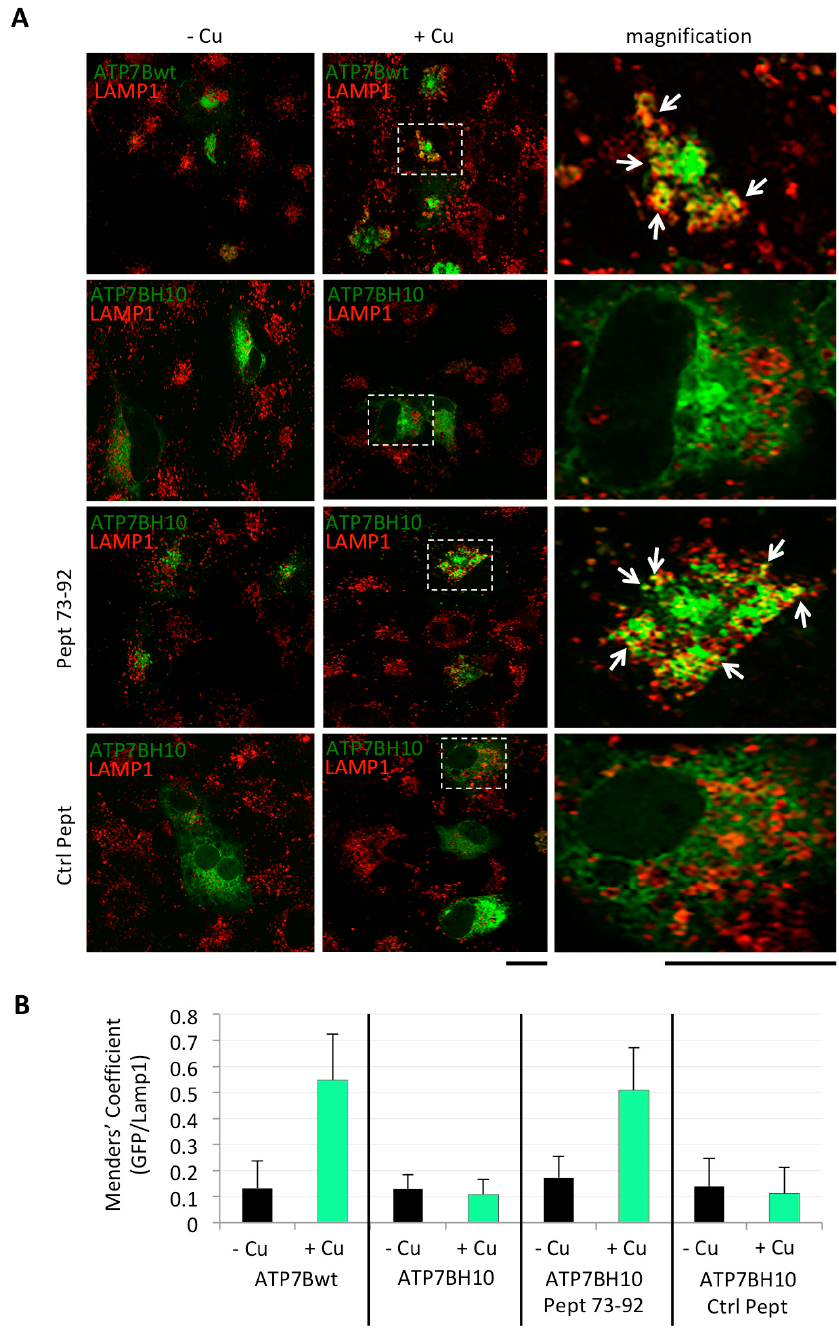
Figure 3. ATP7B-H1069Q, localized in the Golgi complex in cells incubated with Pept 73–92, moves to post-Golgi vesicles in response to Cu overload. ( A ) immunofluorescence analysis of COS7 cells transfected to express GFP-tagged ATP7B or ATP7B-H1069Q (upper two rows), incubated in the presence of untagged Pept 73–92 or control peptide 2 (Ctrl Pept) (lower two rows), and finally incubated in the presence of 200 μ M CuSO 4 as indicated on the top. After fixation, the cells were processed for double confocal immunofluorescence analysis to reveal the endo-lysosomal compartment with the marker LAMP-1. White arrows point to region of GFP and LAMP-1 overlapping signal. Scale bar 10 μ m; ( B ) colocalization analysis of GFP and LAMP-1 signals (means ± SD, n = 20 cells from two independent experiments). Abbreviations as in Figure 1.